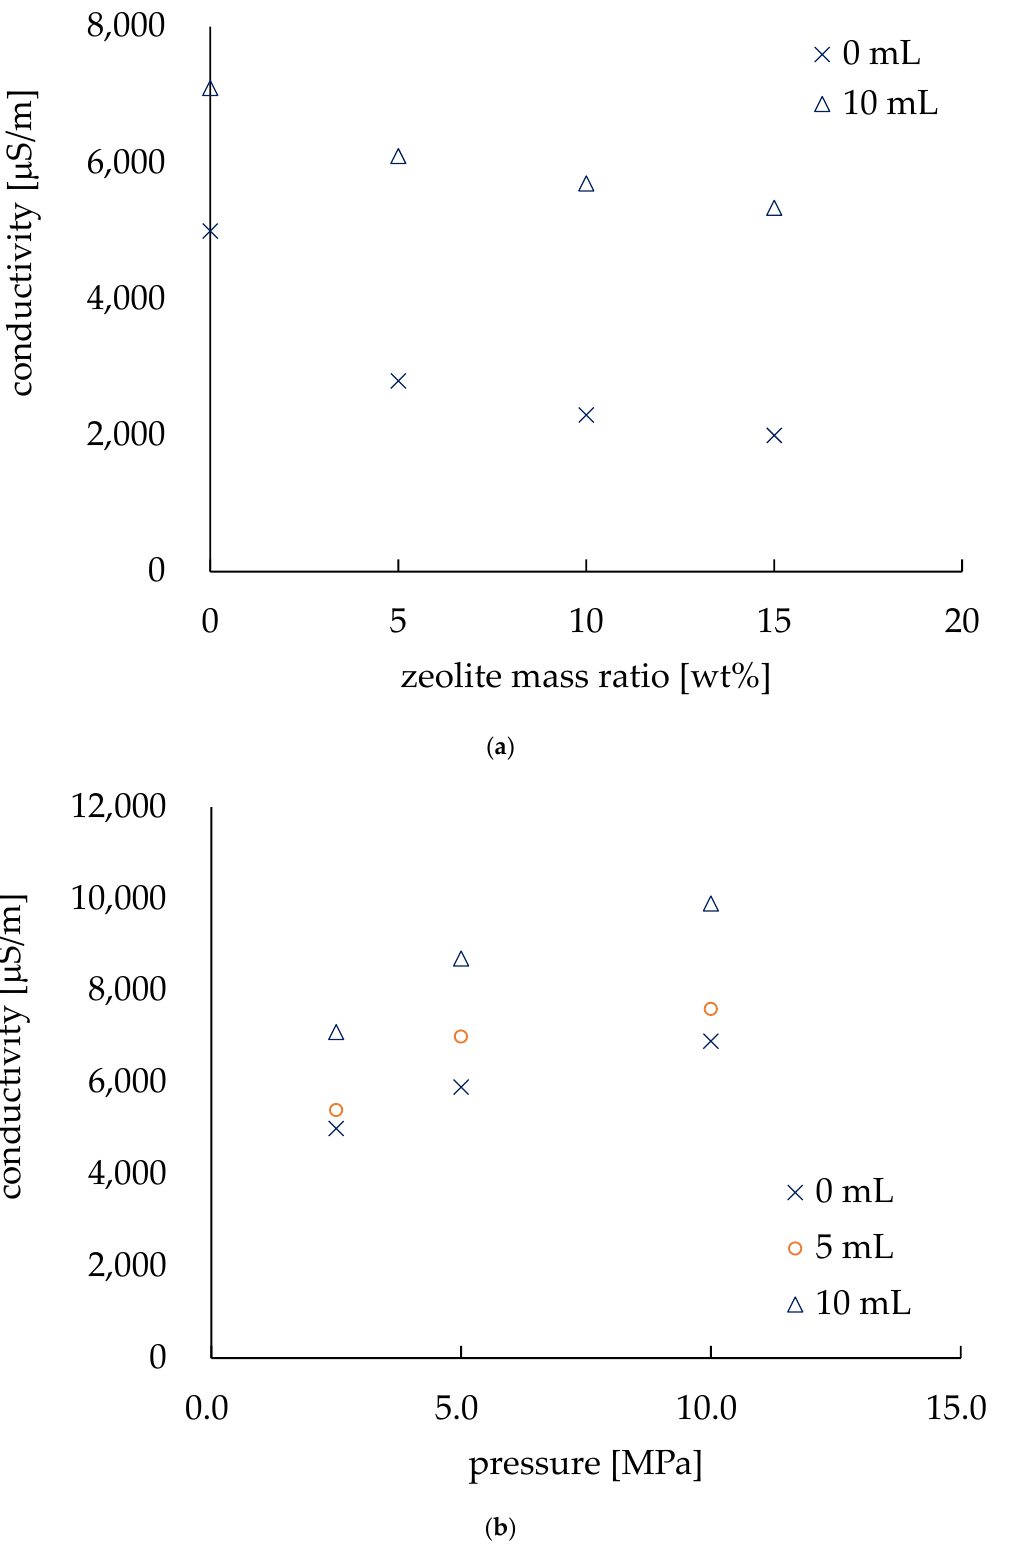
Figure 6. Conductivity evaluation of the electrodes. ( a ) Conductivity varies with the amount of zeolite. ( b ) Conductivity depends on the pressure applied during fabrication.